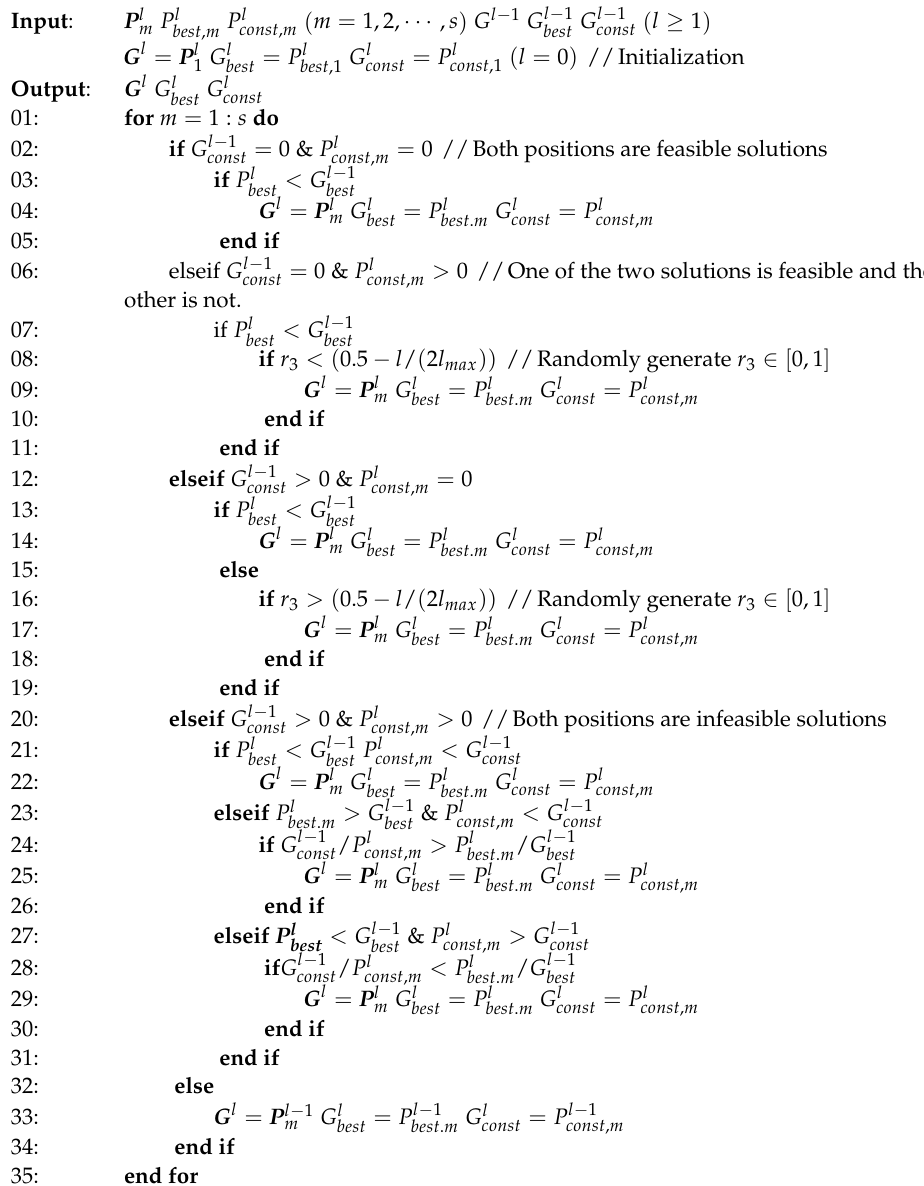
Algorithm 1. Algorithm of global optimal